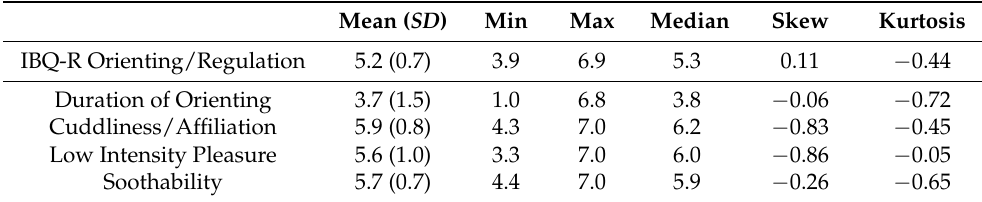
Table 2. Characteristics of regulatory function at Time 1.